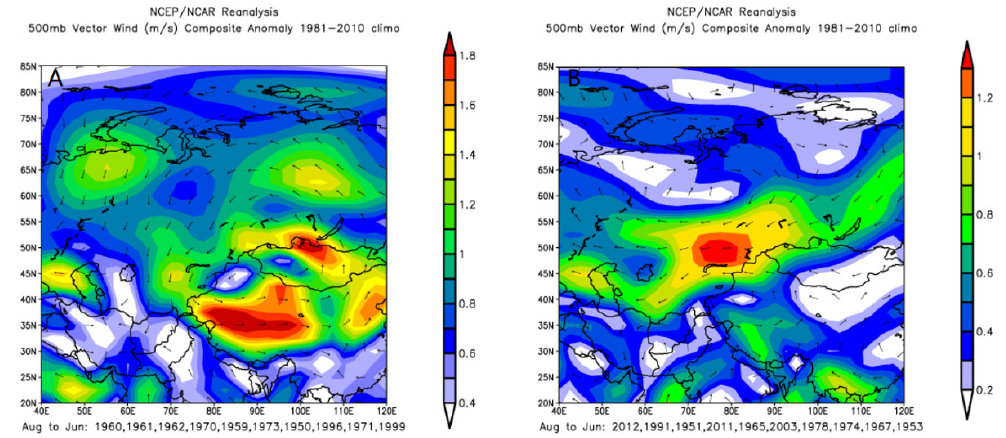
Figure 8. Composite anomaly maps of 500-hPa vector wind (from prior August to current June) for the 10 highest ( A ) and 10 lowest ( B ) runoff years for the runoff reconstruction of the Kaiken River during the period 1948–2013.